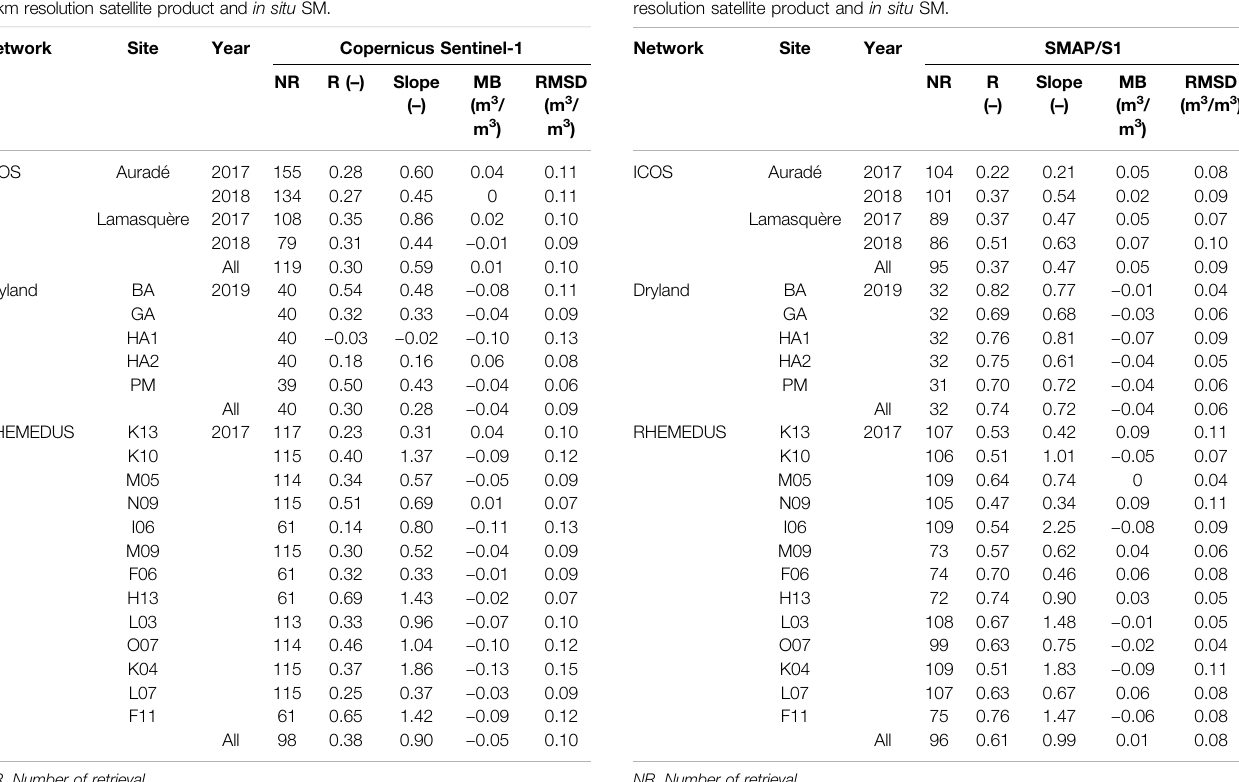
TABLE 4 | Statistical results in terms of correlation (R), slope of the linear regression (Slope), mean bias (MB) and RMSD between Copernicus Sentinel-1 1 km resolution satellite product and in situ SM.